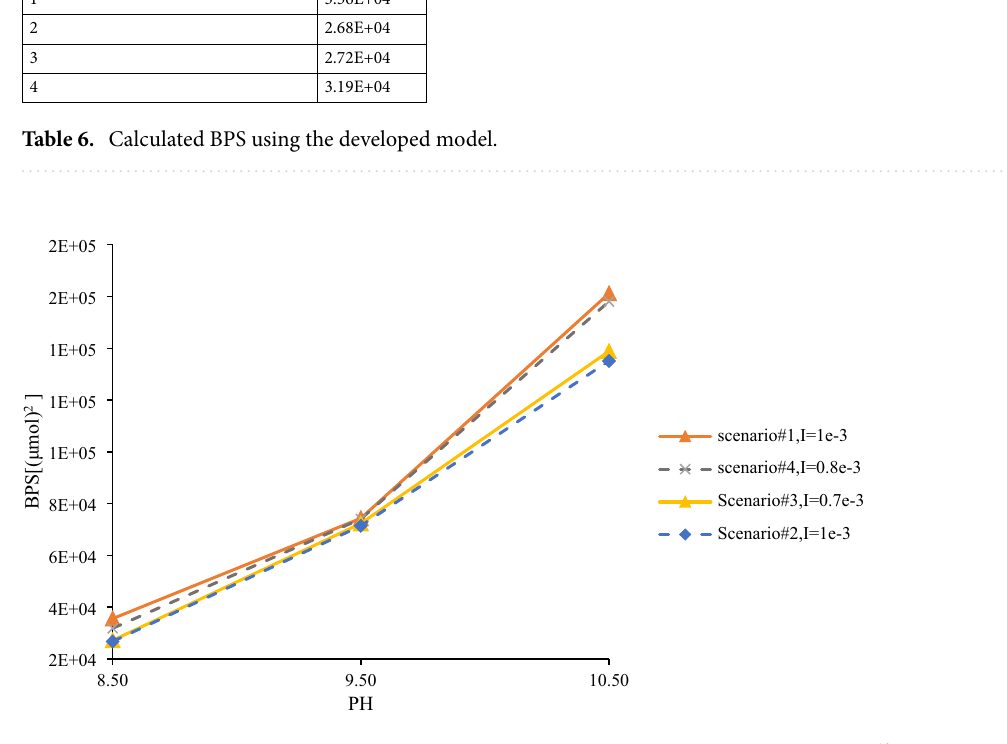
pH = 8.5, I = 0.001 Injection scenario